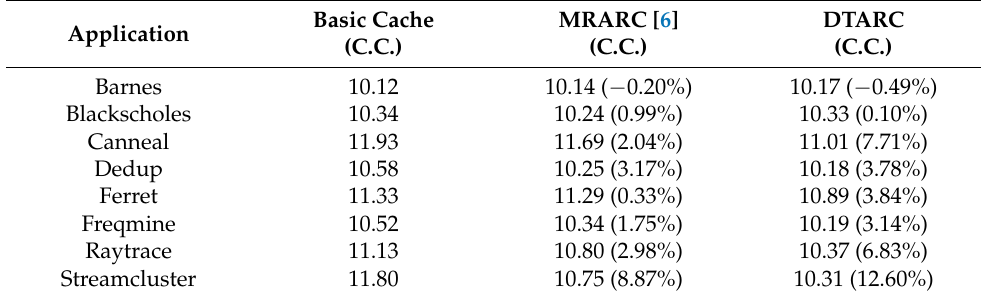
Table 2. Average memory access time of different L2 caches.